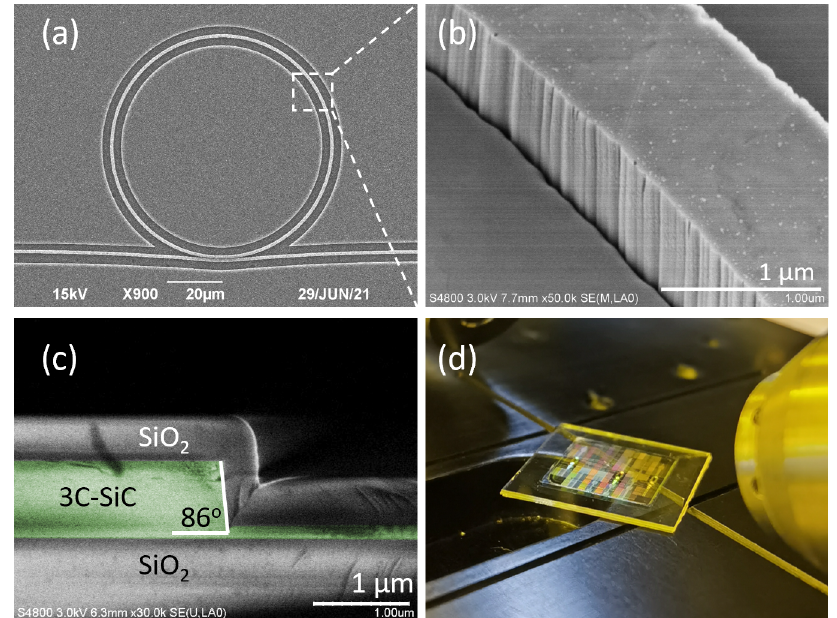
Figure 3. ( a ) A scanning-electron micrograph (top-view) of the fabricated waveguide-coupled microring resonator. ( b ) A zoom-in view showing the waveguide sidewall roughness. ( c ) A cross- sectional view of the fabricated waveguide facet, featuring a sidewall slope of 86°. ( d ) A picture of the 3C-SiCoI chip.